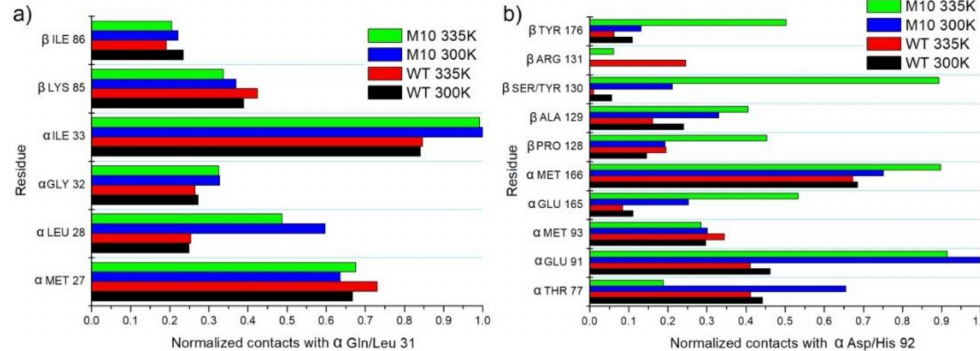
Figure 11. ( a ) Interactions of α Gln / Leu31 with neighbor amino acids. ( b ) Interactions of α Asp / His92 with neighbor amino acids.